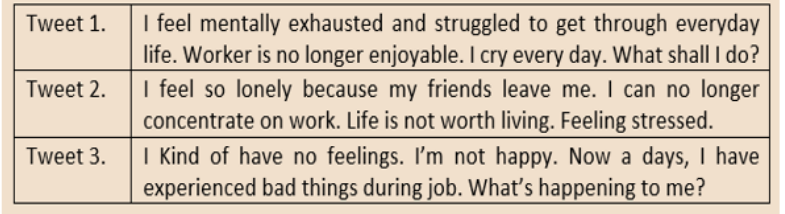
Figure 3. Some depressive tweets from data